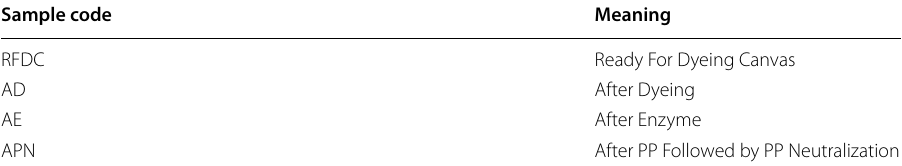
Table 2 Sample codes and meaning